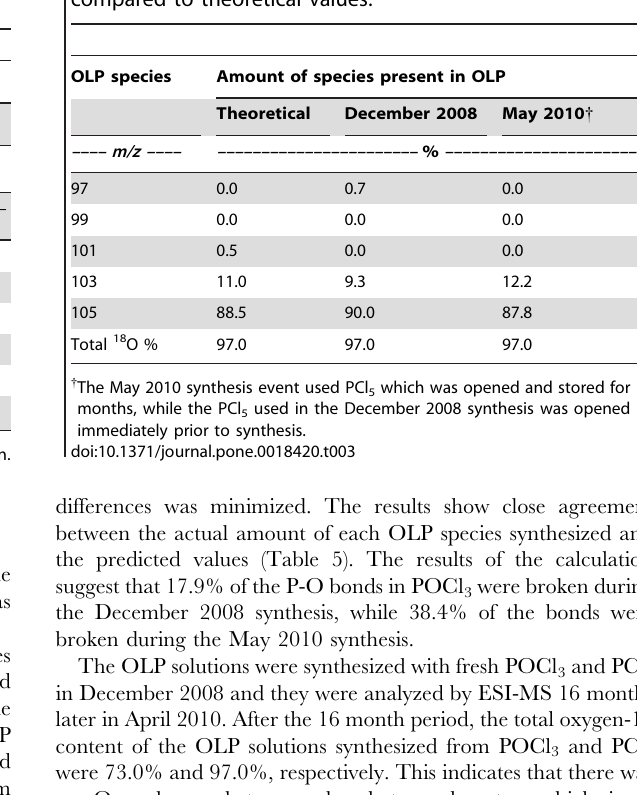
Table 3 . Amount of each oxygen labeled phosphate (OLP) species present in OLP synthesized from PCl 5 during two separate synthesis events (December 2008 and May 2010) as compared to theoretical values.